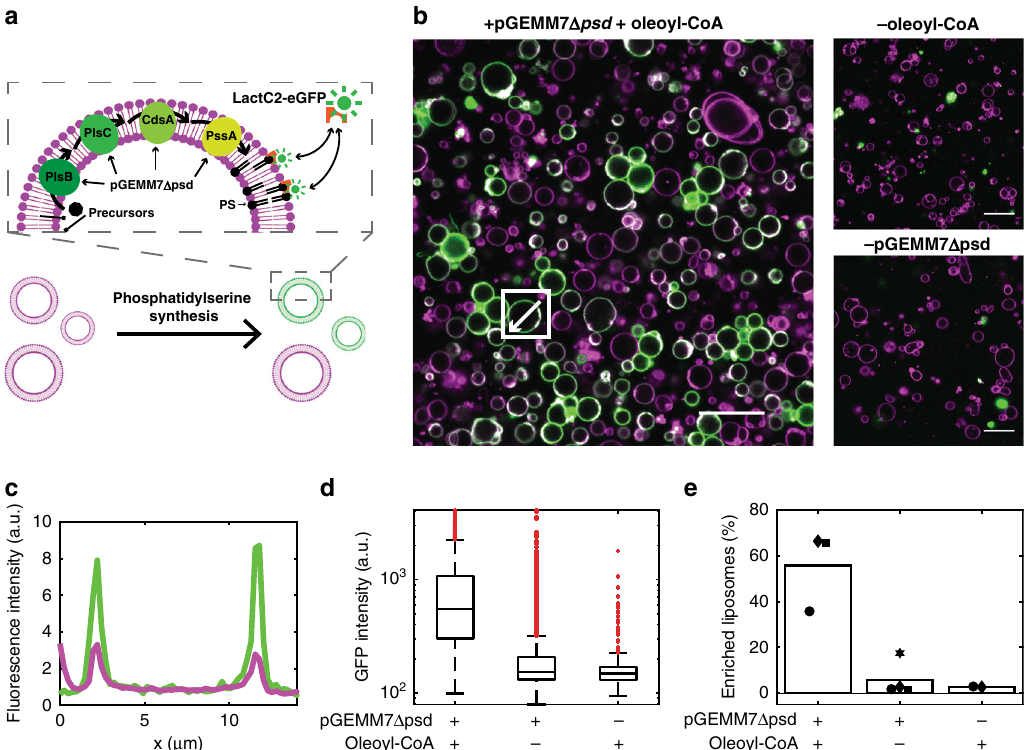
Fig. 5 Single-vesicle imaging of internal PS production using LactC2-eGFP. a Schematic representation of gene expression-coupled PS biosynthesis inside liposomes and fl uorescence imaging using the PS-speci fi c LactC2-eGFP probe. The linear pGEMM7 Δ psd template was expressed within giant vesicles to produce the PlsB, PlsC, CdsA and PssA enzymes which catalyse formation of PS from acyl-CoA and G3P. Membrane-exposed PS recruits the fl uorescent reporter LactC2-eGFP, resulting in accumulated GFP signal in PS-enriched liposomes. b Fluorescence confocal images of liposomes (membrane dye in magenta) producing DOPS from oleoyl-CoA, as illustrated in ( a ). The externally added LactC2-eGFP binds to PS-containing liposomes and stains the membrane in green, as observed in three independent repeats. In a series of negative control experiments, oleoyl-CoA was omitted (four independent repeats), or the pGEMM7 Δ psd DNA was replaced by a DNA coding for an unrelated protein, namely the terminal protein of the ϕ 29 phage (two independent repeats) 55 . Bright spots of clustered LactC2-eGFP molecules that do not co-localise with liposomes are sometimes visible. The LactC2- mCherry variant showed less propensity to form clusters than the eGFP fusion protein (Supplementary Fig. 18) and similar quantitative results were obtained with the two reporters (Supplementary Figs. 17, 18). Scale bars indicate 20 μ m. c Line pro fi les of LactC2-eGFP intensity (green) and Texas Red membrane dye intensity (magenta) of the liposome highlighted in ( b ). d Box-plot representation of the single-vesicle average LactC2-eGFP intensity values for the indicated samples. Data were pooled from (from left to right) three, four and two independent repeats, corresponding to 4048, 3642 and 569 liposomes analysed, respectively. Membrane-localised GFP fl uorescent intensity is signi fi cantly higher when both DNA and oleoyl-CoA were present (left) compared to negative controls without oleoyl-CoA (middle) or DNA (right), with p < 0.0001 (two-sample Welch ’ s t -test). e Percentage of PS-enriched liposomes for the three types of samples analysed in ( d ) with results from independent experiments indicated by black symbols, with identical symbols referring to experiments performed in parallel. Bar height represents the mean percentage of PS-enriched liposomes. The amount of PS-enriched liposomes is signi fi cantly higher when both DNA and oleoyl-CoA were present compared to the two negative controls, with p < 0.04 (two-sample Welch ’ s t -test). Source data are available for ( d , e ).